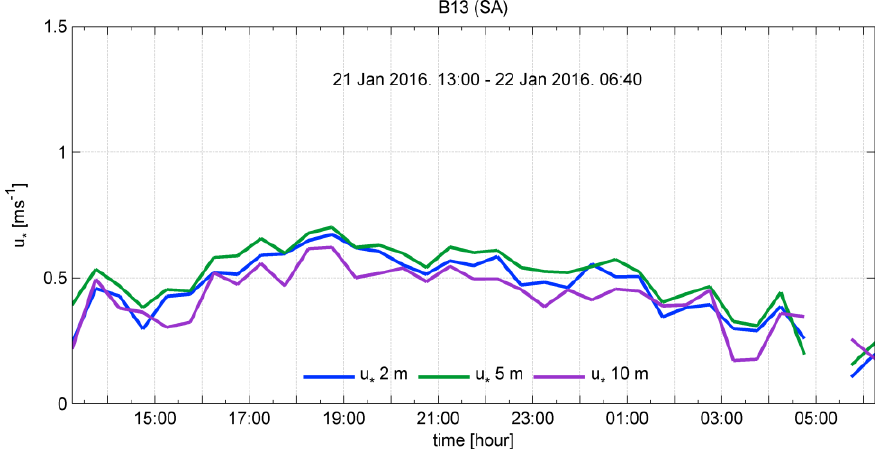
Figure 15. As with Figure 13, but for the bora episode B13 (SA).